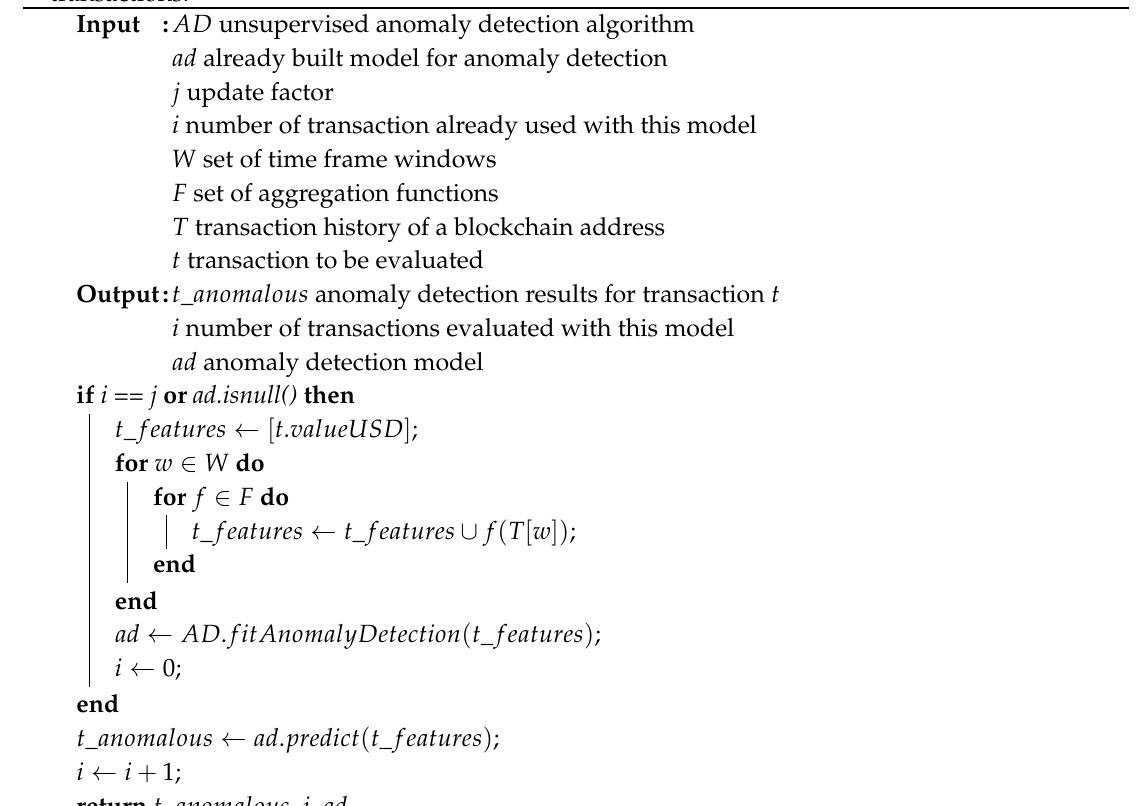
Algorithm 1: Pseudocode of proposed method for identification of anomalous blockchain